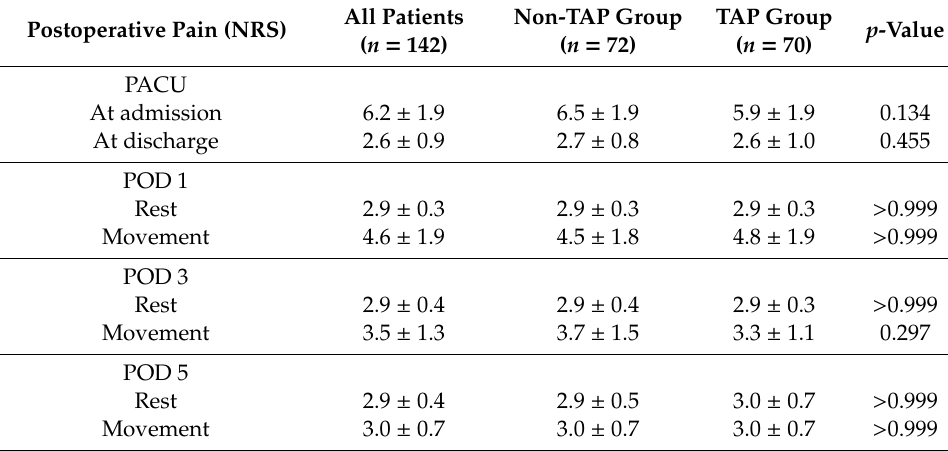
Table 3. Postoperative pain score.